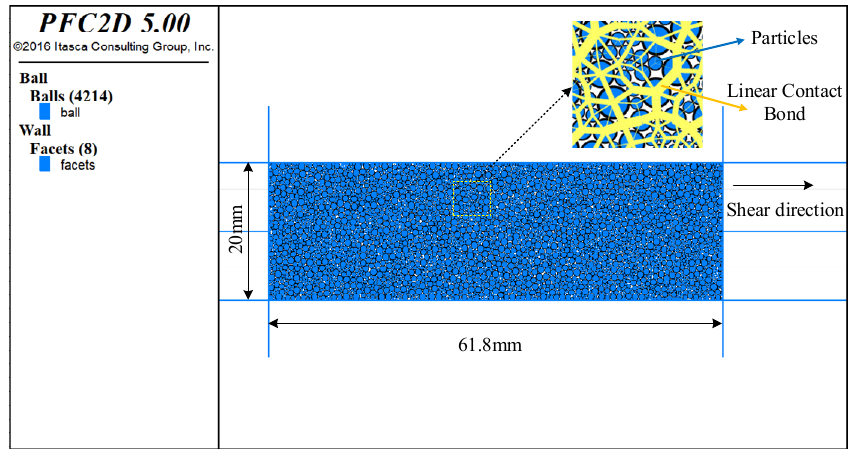
Figure 3. DEM direct shear model.